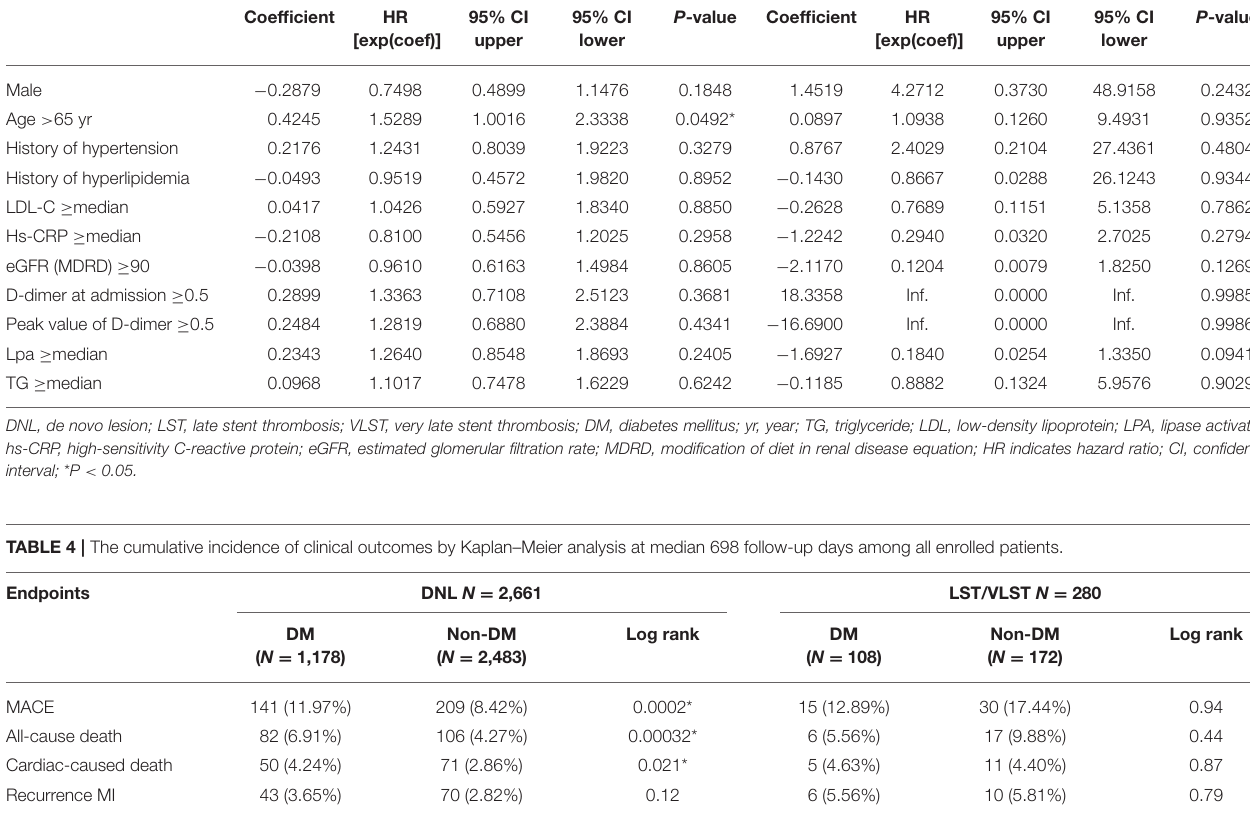
TABLE 3 | Multivariate Cox regression analysis of patients with divided into DNL and LST/VLST. Variables DNL patients with DM ( N = 1,177)